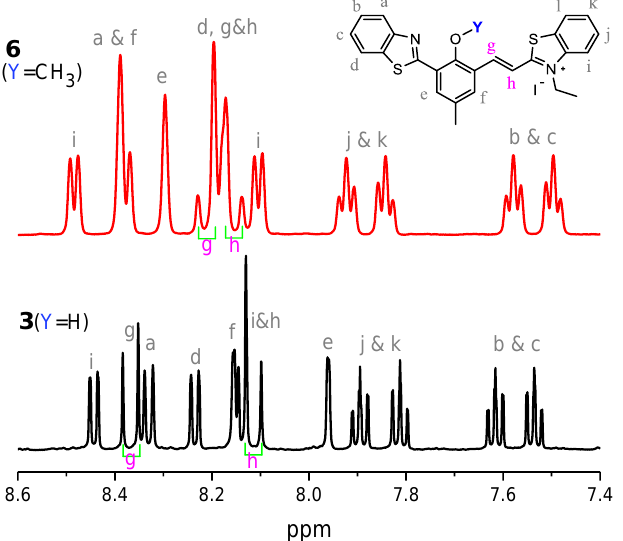
Figure 2. 1 H NMR spectra of 3 and 6 in DMSO-d 6 , in which the J coupling patterns of the vinyl protons are indicated. The alkyl protons are not shown for clarity.